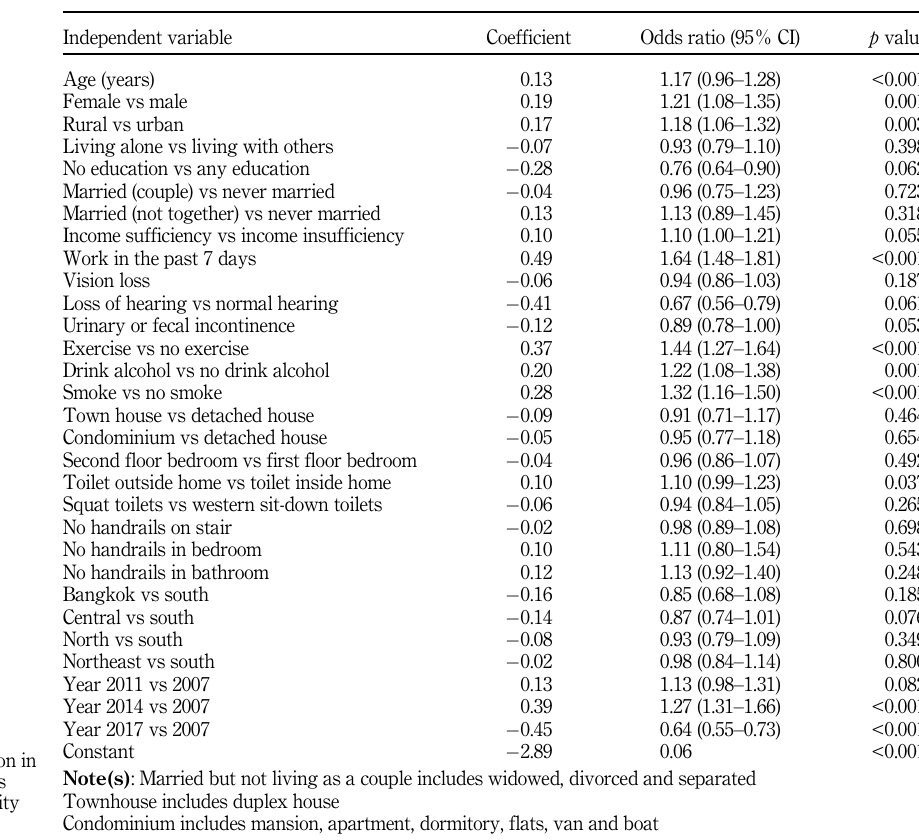
Table 3. Logistic regression in overall four years (sample probability